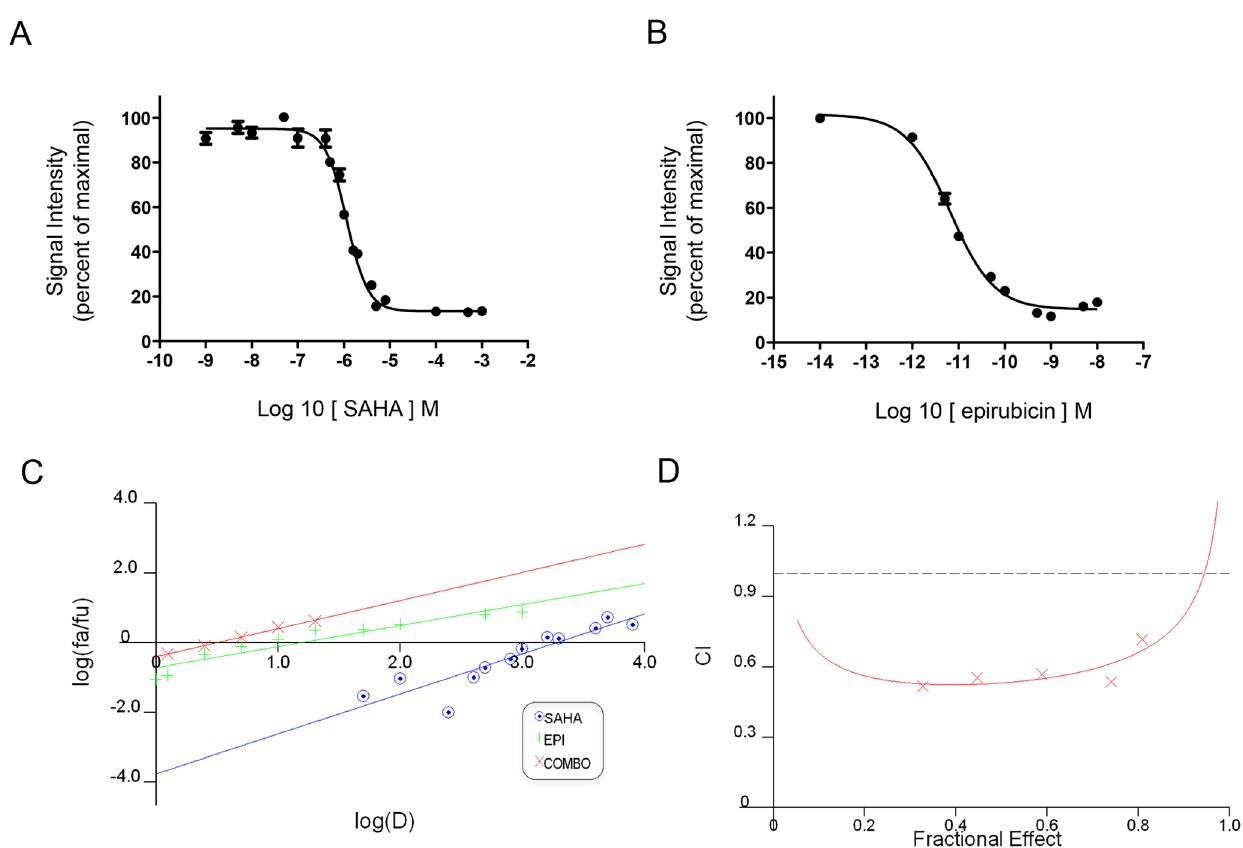
Figure 4. Drug combination analysis. A and B) Dose response curves for SAHA and Epirubicin; C) Median-effect plot; D) Algebraic estimate of the combinational index (CI) for the combination of epirubicin with SAHA relative to the fraction of affected cells.